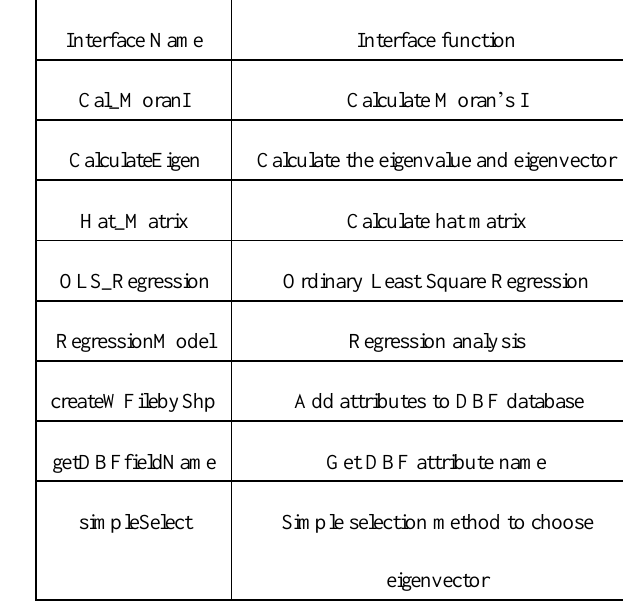
Table 4. Introduction for web service interface and